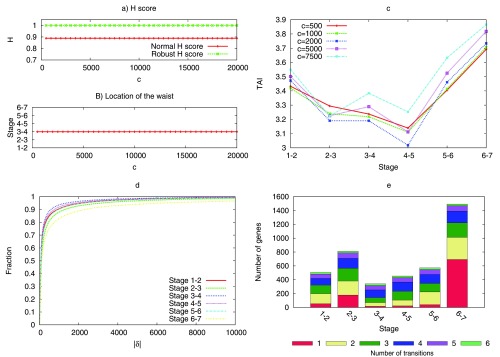

Arabidopsis thaliana results using absolute expression levels.Graph (
a) shows the hourglass score (normal and robust) as a function of the transition threshold
c. Graph (
b) shows the location of the hourglass waist (stage-pair) as a function of the transition threshold
c. Graph (
c) shows the Transcriptome Age Index of transitioning genes for five different values of
c (chosen so that the number of genes with known age index assigned to each stage-pair is at least 170). Graph (
d) shows the CDFs of the expression level absolute variations |
δ| across successive stage-pairs. Graph (
e) shows the transitioning genes with
c = 5000. The transitioning genes constitute 8% of all genes in that dataset. 48% of those genes transition in a single stage-pair. Of the remaining, 38% transition only in consecutive stage-pairs. [Dataset 13].